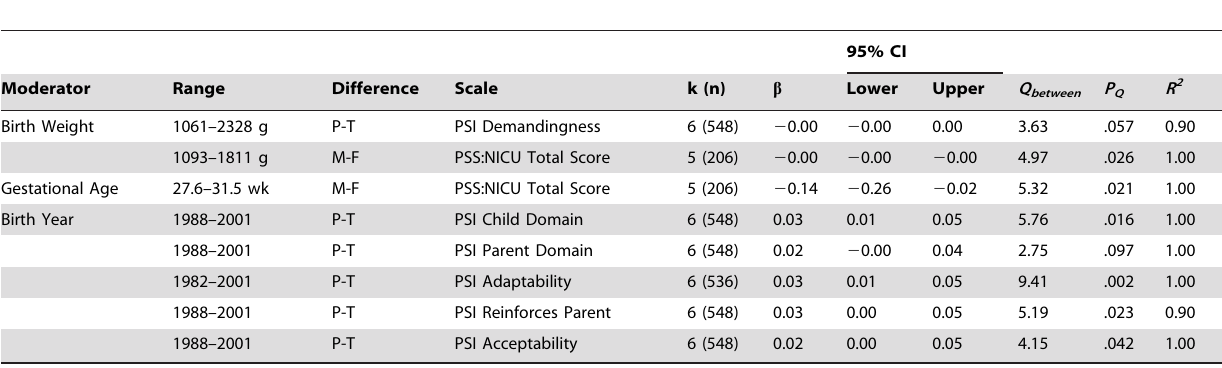
Table 9. Moderator Analyses for Meta-Analytic Preterm-Term and Mother-Father Standardized Differences in PSI and PSS:NICU